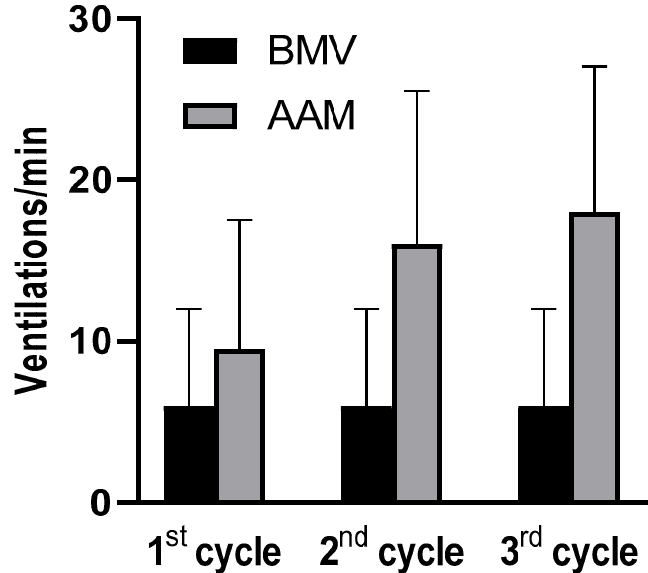
Figure 2. Ventilation rates during the first three cycles of CPR. Bars represent means, error bars indicate one SD. Cycles refer to blocs of chest compressions and ventilation between two defibrillations. BMV = bag-mask ventilation; AAM = advanced airway management; SD = standard deviation; CPR = cardiopulmonary resuscitation. In each cycle, ventilation rates differed significantly ( p < 0.001) between the groups.